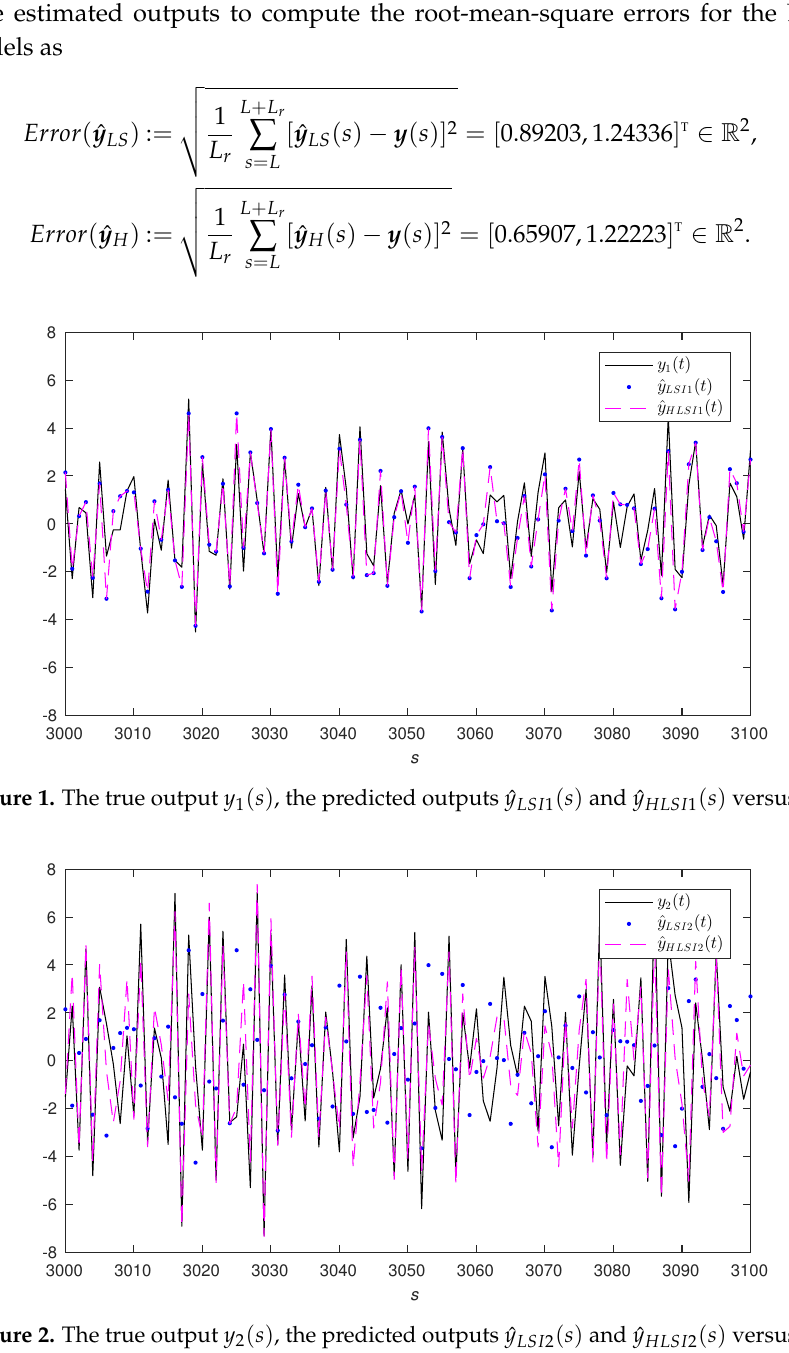
Figure 2. The true output y 2 ( s ) , the predicted outputs ˆ y LSI 2 ( s ) and ˆ y HLSI 2 ( s ) versus s